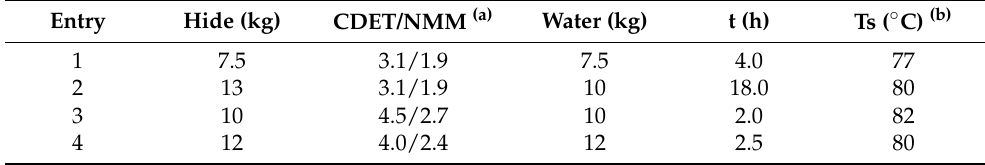
Table 4. Tanning tests on calf hide in the presence of CDET/NMM system.